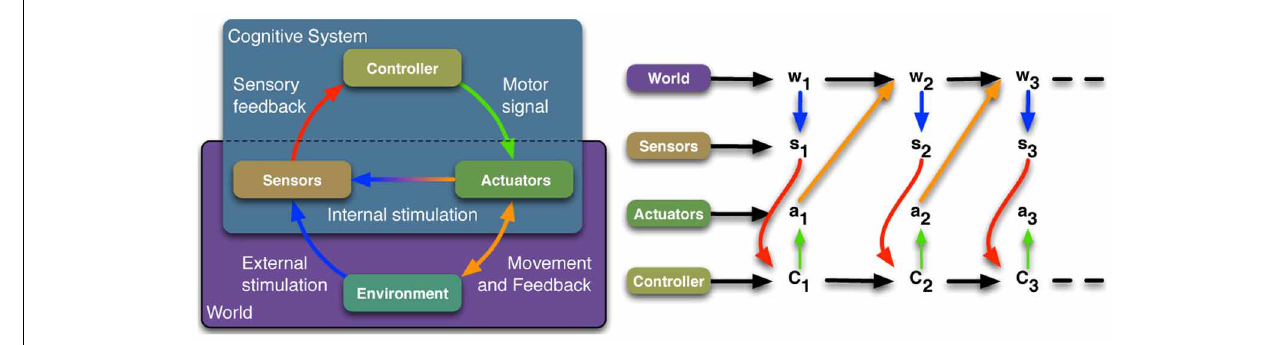
FIGURE 1 | The sensorimotor loop. Left: Schematic diagram of a cognitive system with its interaction with the world. Right: Corresponding causal